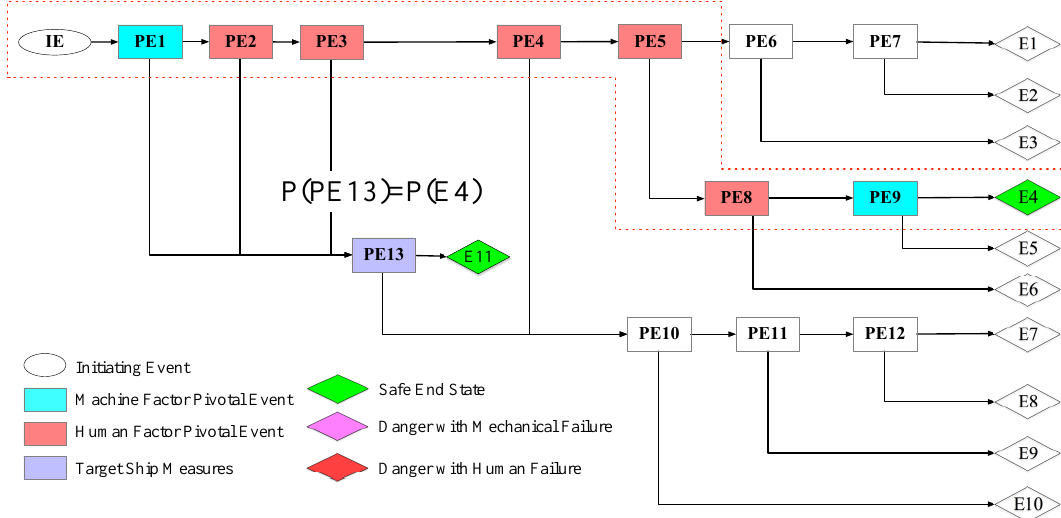
Figure 6. Method of determining the TS Measures (PE 13).